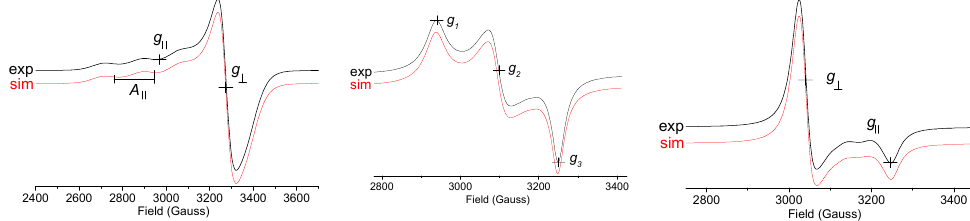
Figure 5. X-band EPR spectra of microcrystalline samples of [Cu(Ina) 4 (H 2 O) 2 ](BF 4 ) 2 ( 1 ) ( left , frequency = 9.455063 GHz, simulation in red with parameters in Table 3), (Cu(H-Aba) 2 Cl 4 ) ( 17 ) ( middle , frequency = 9.454244 GHz, simulation in red), and [Cu 2 (Aba) 2 (H 2 O) 3 (NO 3 ) 3 ](NO 3 ) ( 14 ) ( right , frequency = 9.448669 GHz, simulation in red), all measured at 298 K.